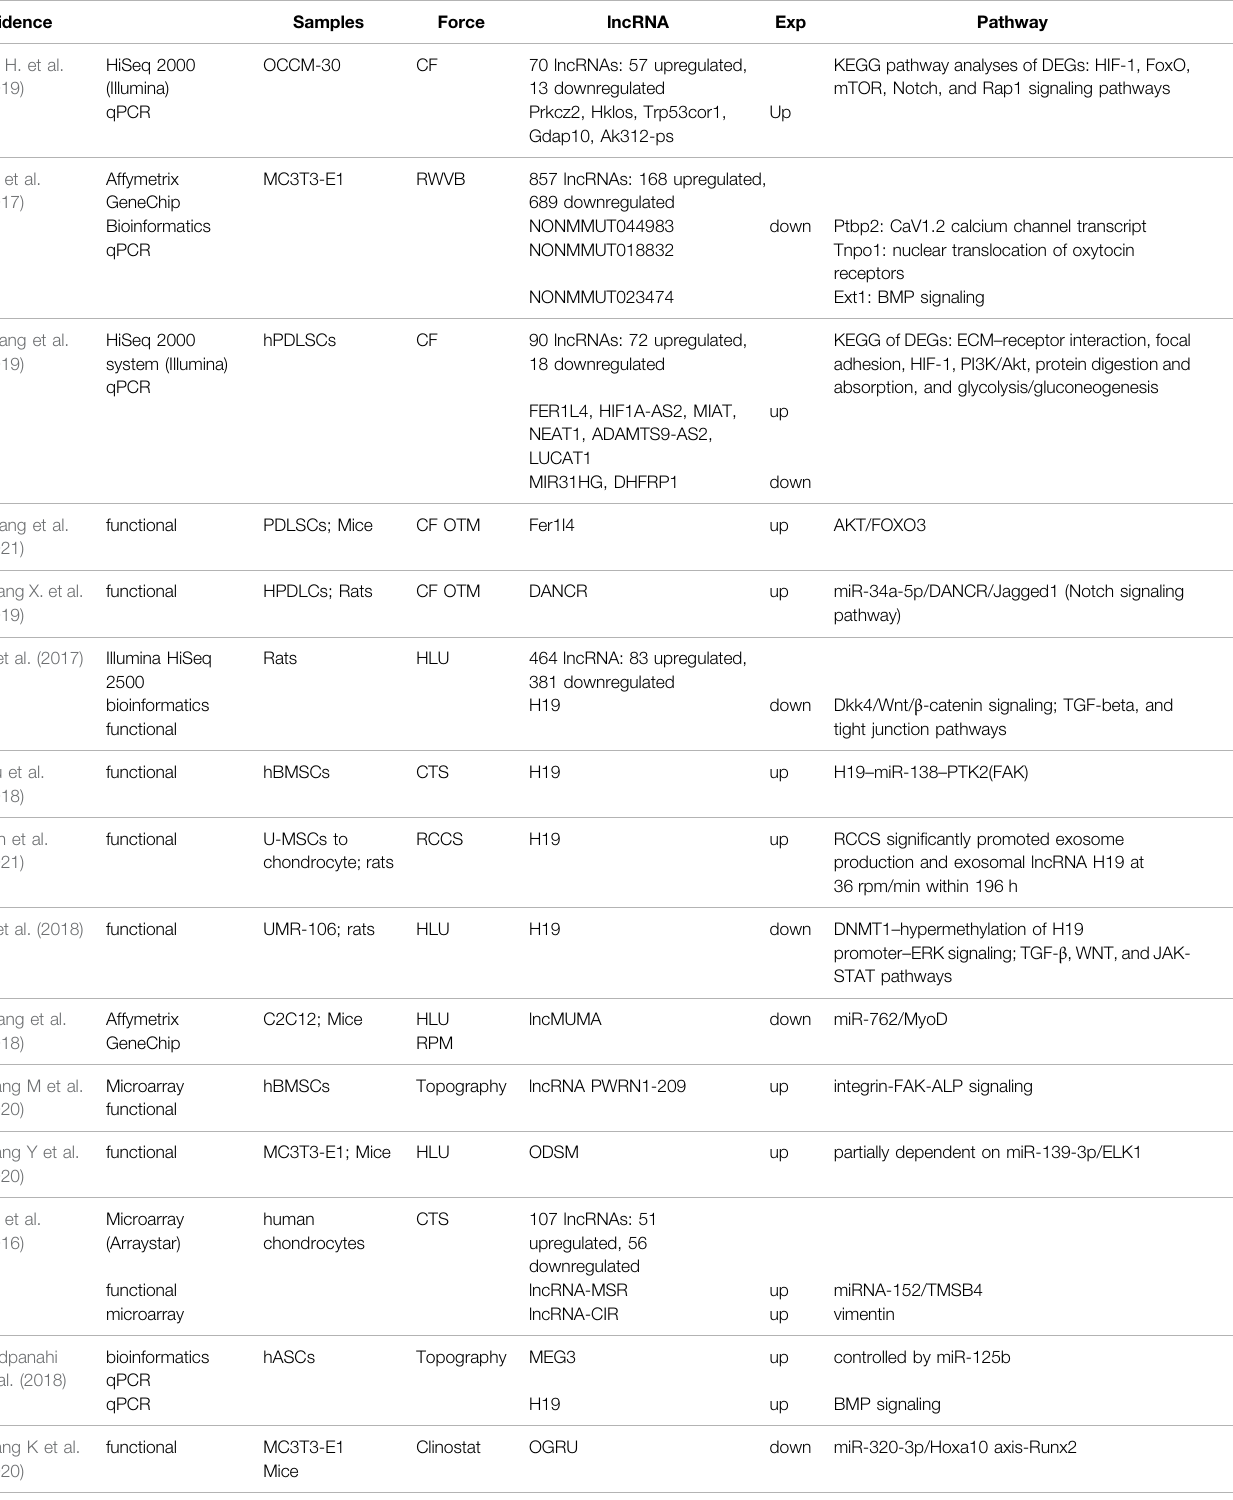
TABLE 4 | Creditable force-sensitive lncRNAs and related